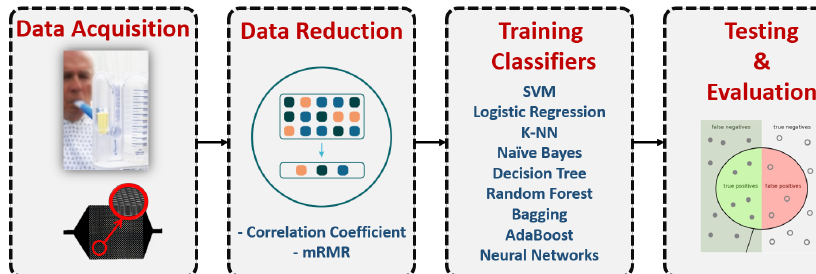
Figure 1. Methodology procedure.